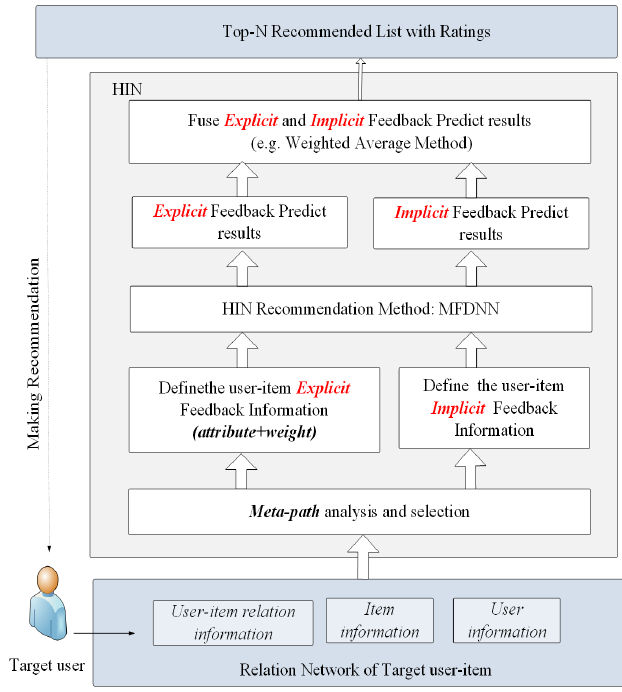
Figure 2. Architecture of the proposed